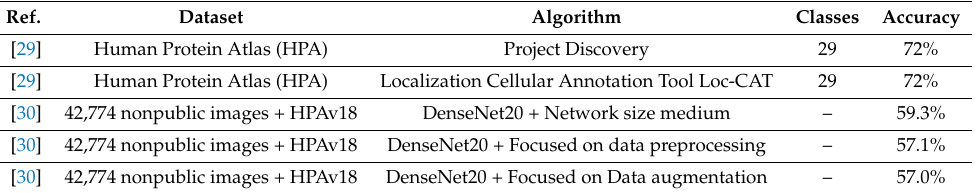
Table 1. Cells classification.